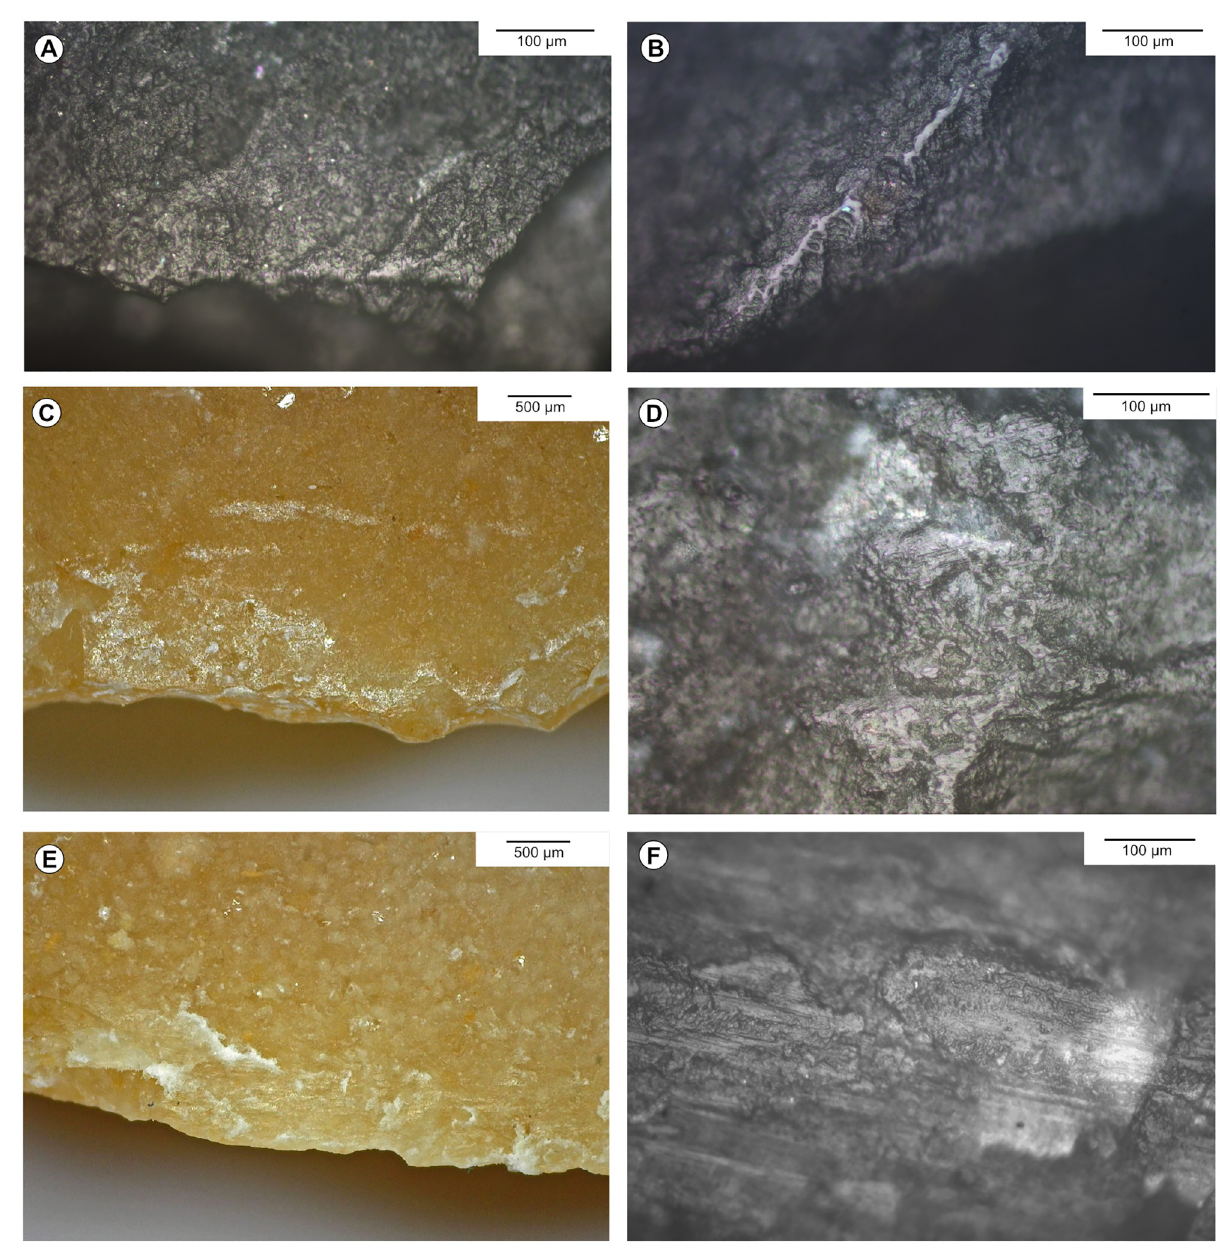
Fig 6. Experimental bone and antler working traces on flint. A-Scraping fresh bone, 180 mn. B-Sawing moisturised antler, 15 mn. C, D-Sawing dry bone, 10 mn. E, F-Sawing dry antler, 10 mn.